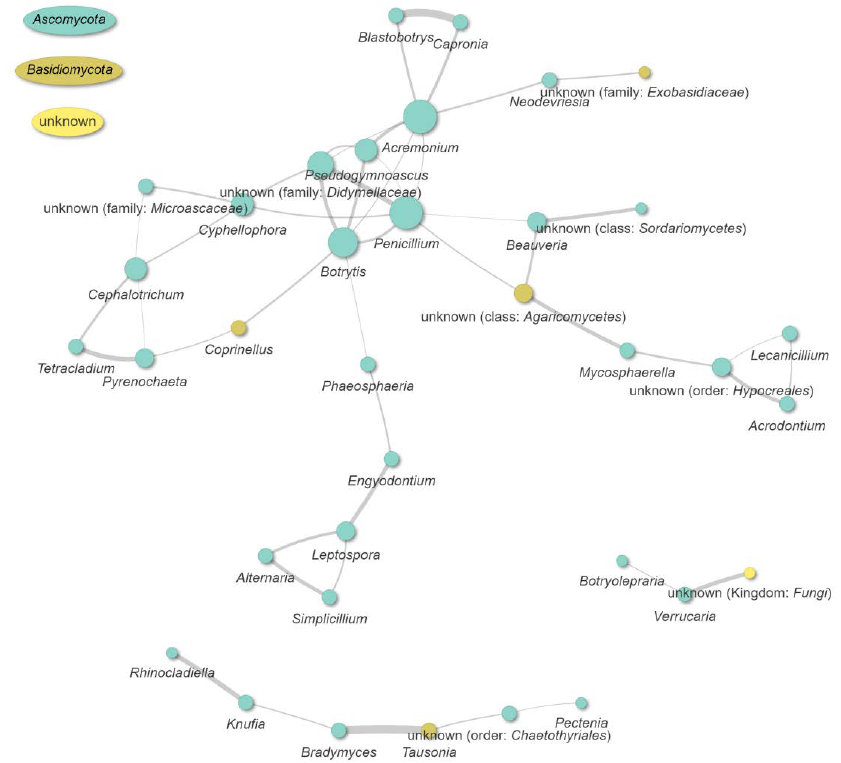
Figure 12. A genus-level network based on weighted Jaccard distance. Distances lower than 0.6 are shown as edges. Only those taxa that were present in any sample with at least 0.5% of occurrence were analyzed.